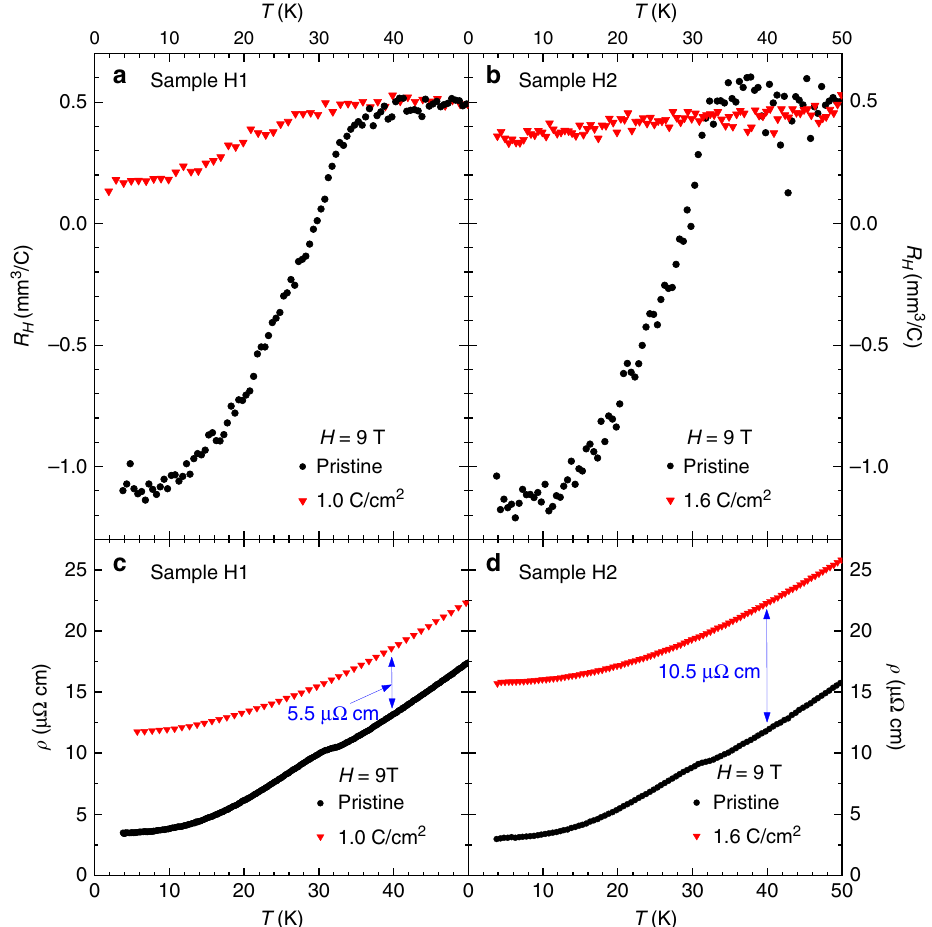
Fig. 6 Temperature dependence of Hall resistivities of two NbSe 2 samples measured under 9 T. a Sample H1 before and after 1.0 C cm − 2 irradiation and b sample H2 before and after 1.6 C cm − 2 irradiation. c , d In- fi eld resistivities were also measured for both samples that clearly show the increase of disorder: Δ ρ ( T = 40 K ) = 5.5 and 10.5 μΩ cm for samples H1 and H2,